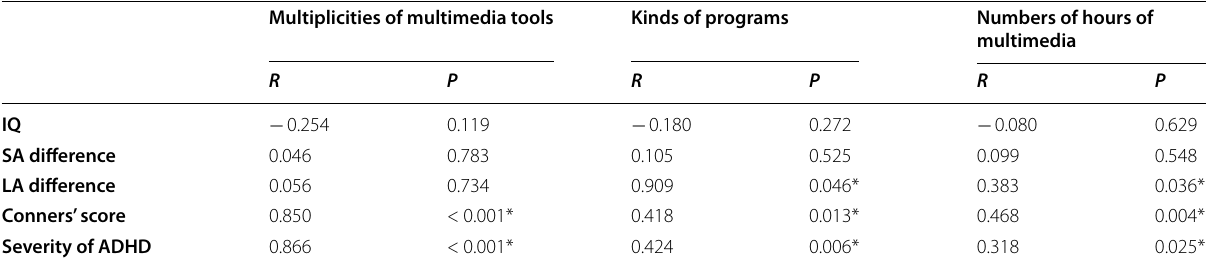
Table 7 Correlative analysis between significant items of the constructed questionnaire and other studied parameters